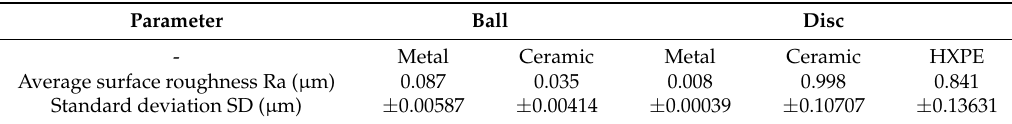
Figure 1. Schematic illustration of the measurement configuration. Table 1. Surface topography parameters of the test samples.